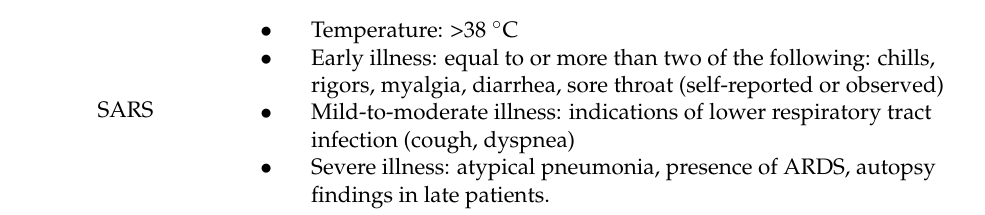
Table 1. Clinical criteria definition of